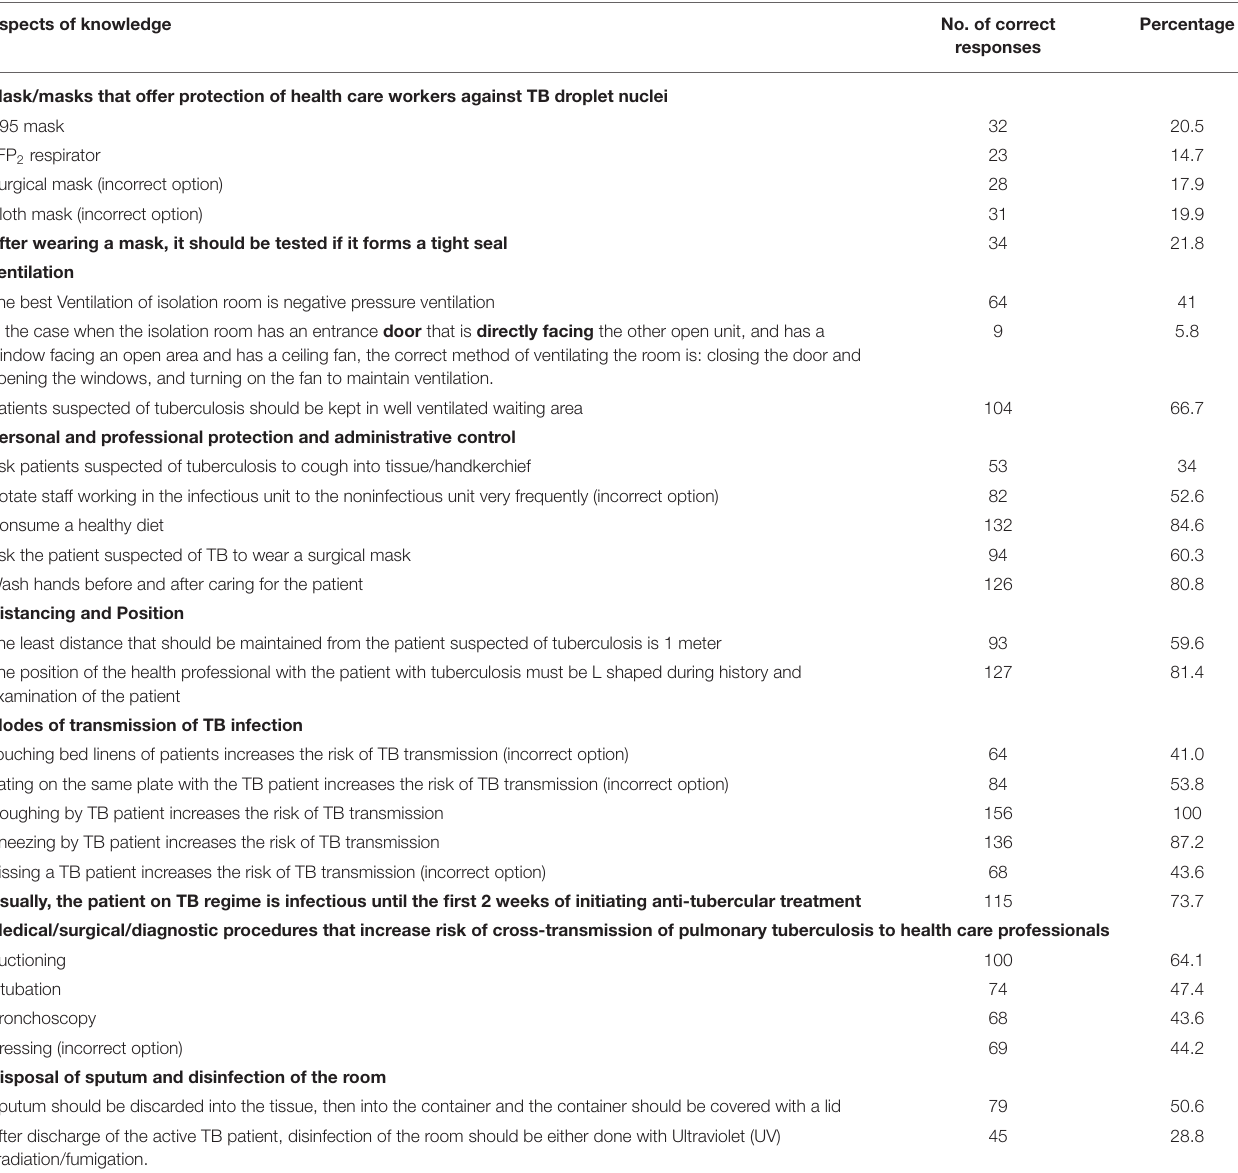
TABLE 2 | Aspects of knowledge of the prevention and control of tuberculosis (TB) among nurses n = 156.